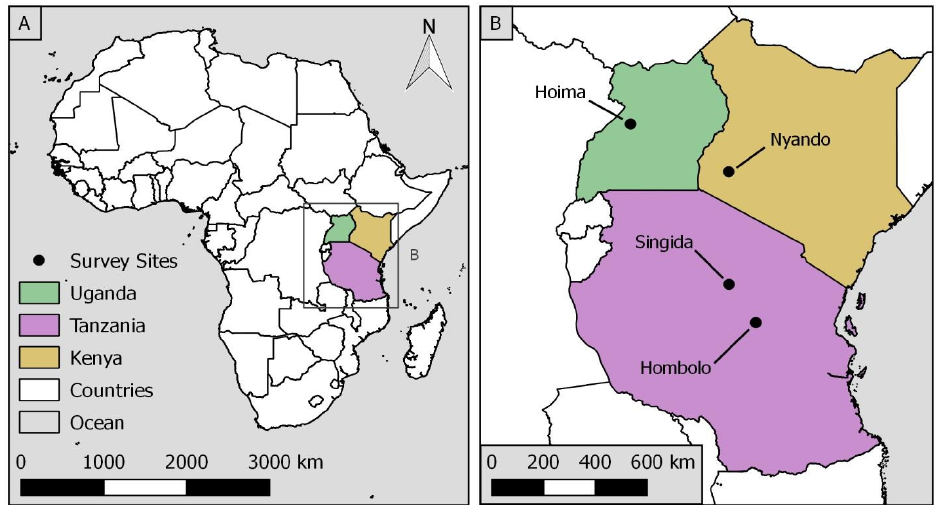
Table 1. Geographical and farming characteristics of the study sites.